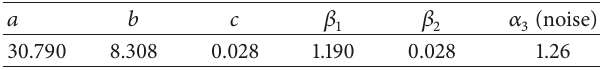
Table 4: Estimated parameters of improved SGDP in